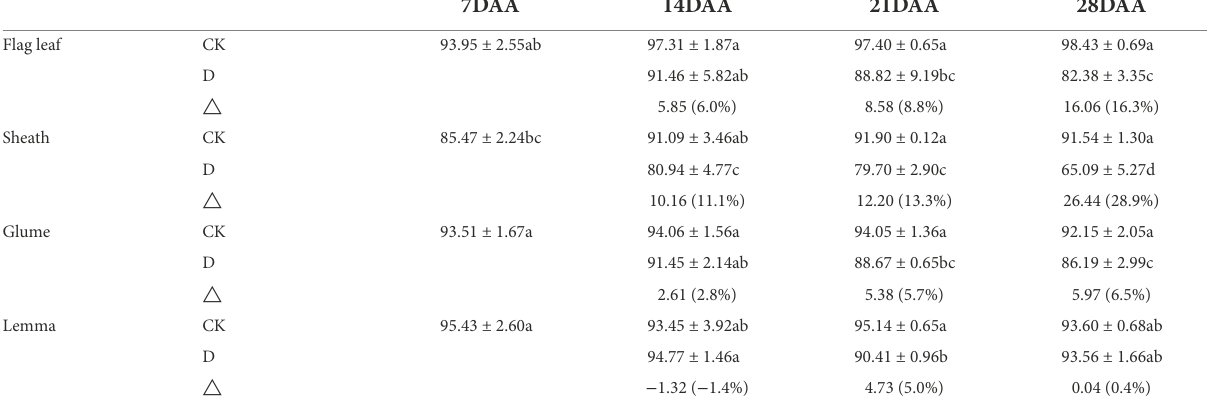
TABLE 3 The relative water content of the flag leaf, the sheath, the glume and the lemma under drought stress.